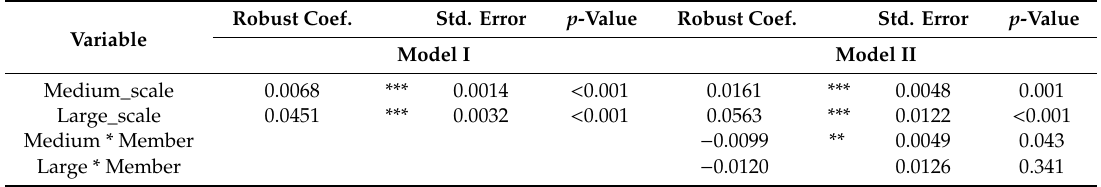
Table 4. Mean regression of participation probability on size and